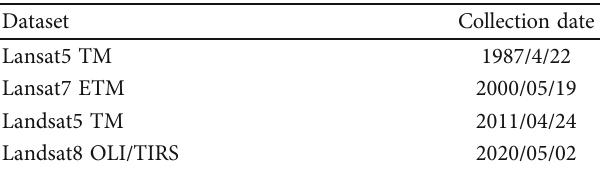
Figure 1: The geographical location and meteorological station distribution in the study area. Table 1: Dataset